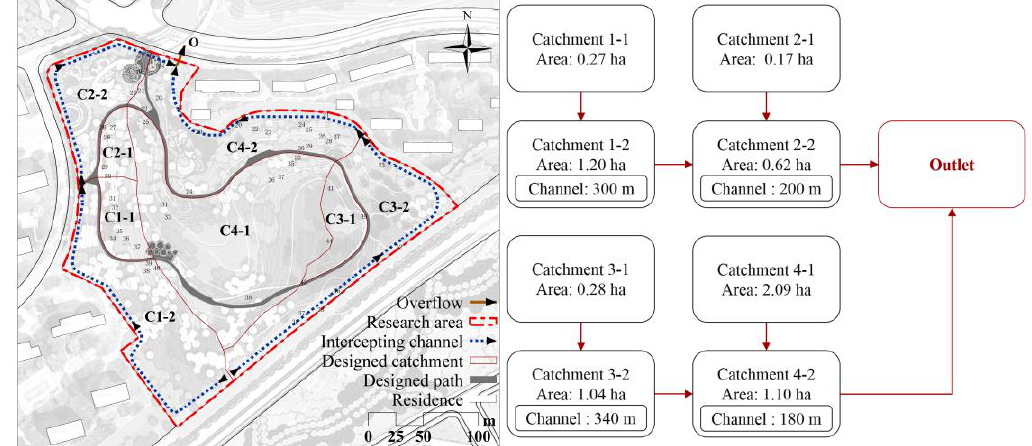
Figure 4. Facilities layout and design workflow diagram for BS.